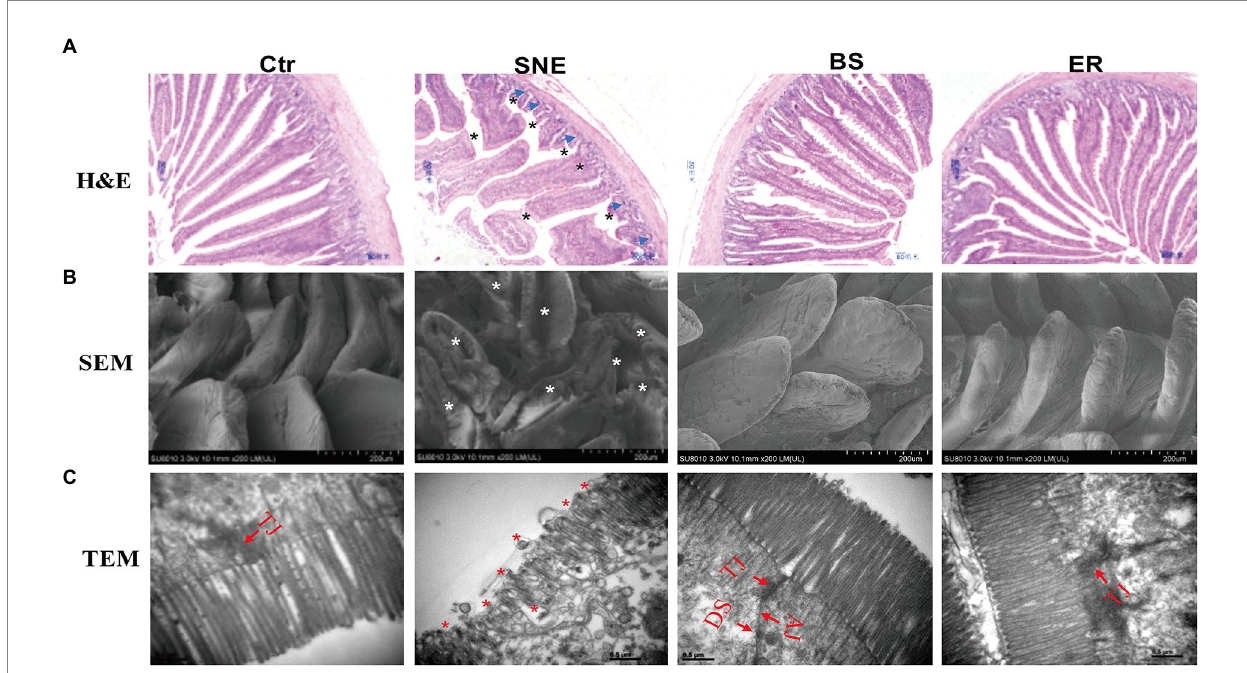
FIGURE 2 (A) Histopathology of the intestinal mucosa analyzed by H&E staining (top, scale bars = 80 μ m). (B) Scanning electron micrograph (bottom, scale bars = 200 μ m) and (C) transmission electron micrographs (bottom, scale bars = 0.5 μ m) of jejunal brush border in broilers. TJ, tight junction; AJ, adherens junction; DS, desmosomes. Asterisk shows the pathology. Blue arrows show the features of necrotic cell death. The abbreviation of Ctr, SNE, BS and ER have the same meaning as Table 3.